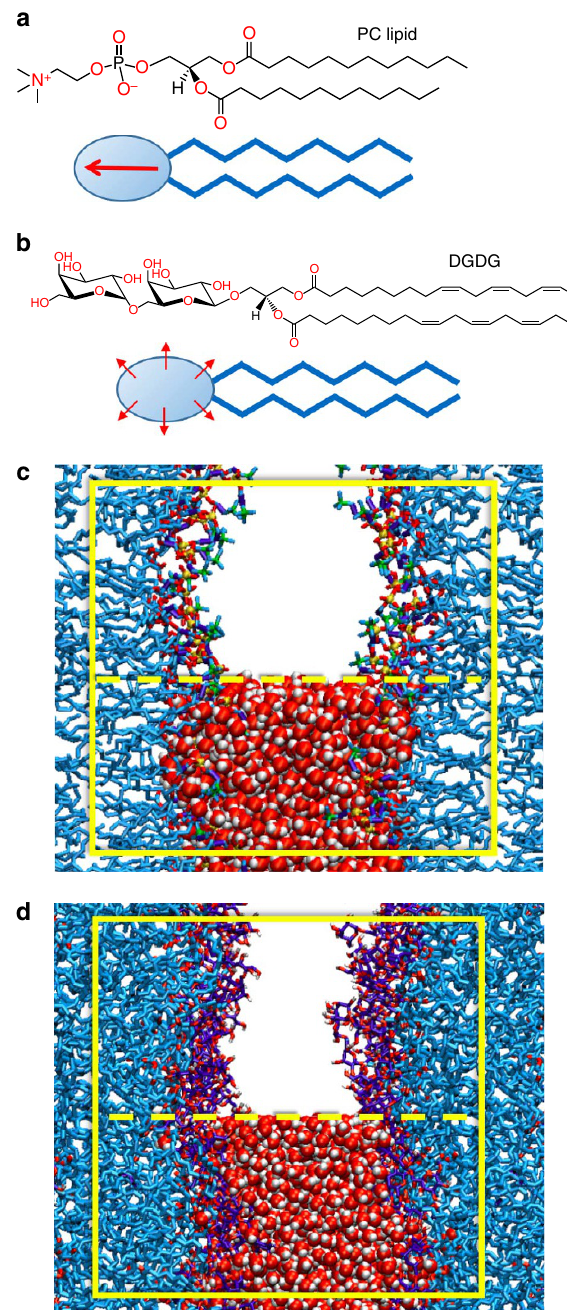
Figure 1 | Lipid structures and simulation set-up. Chemical structures of a PC lipid ( a ) and of the glycolipid DGDG ( b ) as representatives of two fundamentally different lipid classes found in nature: Lipids with a headgroup chemistry dominated by one large electric dipole and lipids whose headgroups comprise multiple small electric dipoles in the form of OH groups. Both classes are schematically illustrated below the chemical structures. Dipoles are indicated by arrows. ( c , d ) Simulation snapshots of interacting DLPC and DGDG membranes, respectively, both at a large separation of D w ¼ 2.3nm. With periodic boundary conditions in all three directions, the simulations represent a periodic stack of membranes with adjustable hydration level. The simulation boxes are indicated with bright rectangles. For illustration, water molecules are only shown in the lower half of the